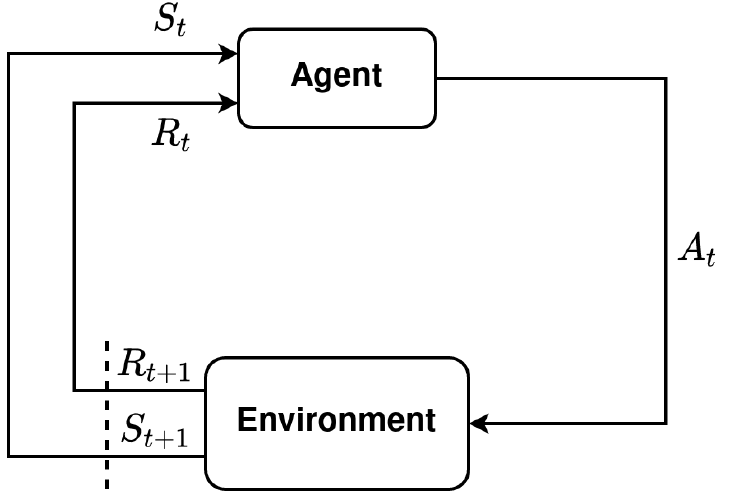
Figure 2. Interactions between an agent and its environment in an RL